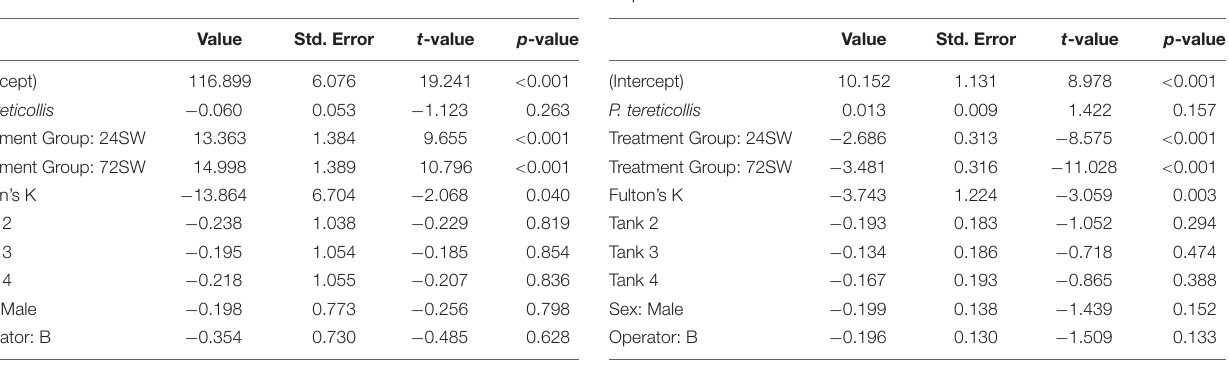
TABLE 5 | Parameter estimates from the linear model where glucose was the response